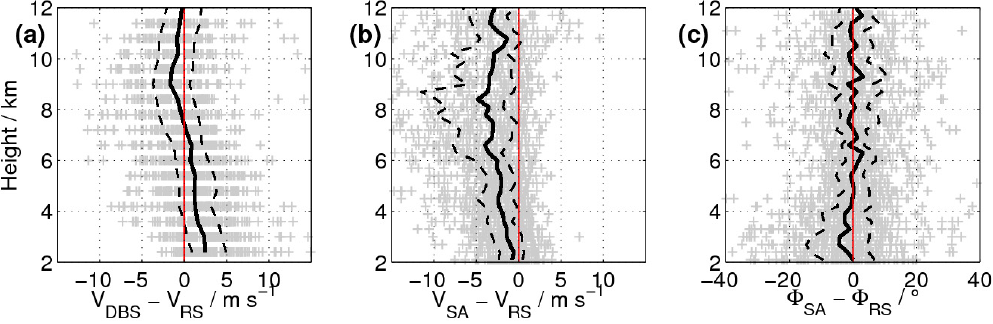
Fig. 3. Differences of wind speed obtained from Doppler experiment (a) , spaced antenna wind speed (b) , and direction (c) between the ALWIN VHF radar and radiosondes (crosses). The solid line represents the median height profile for all simultaneous measurements and the dashed lines the